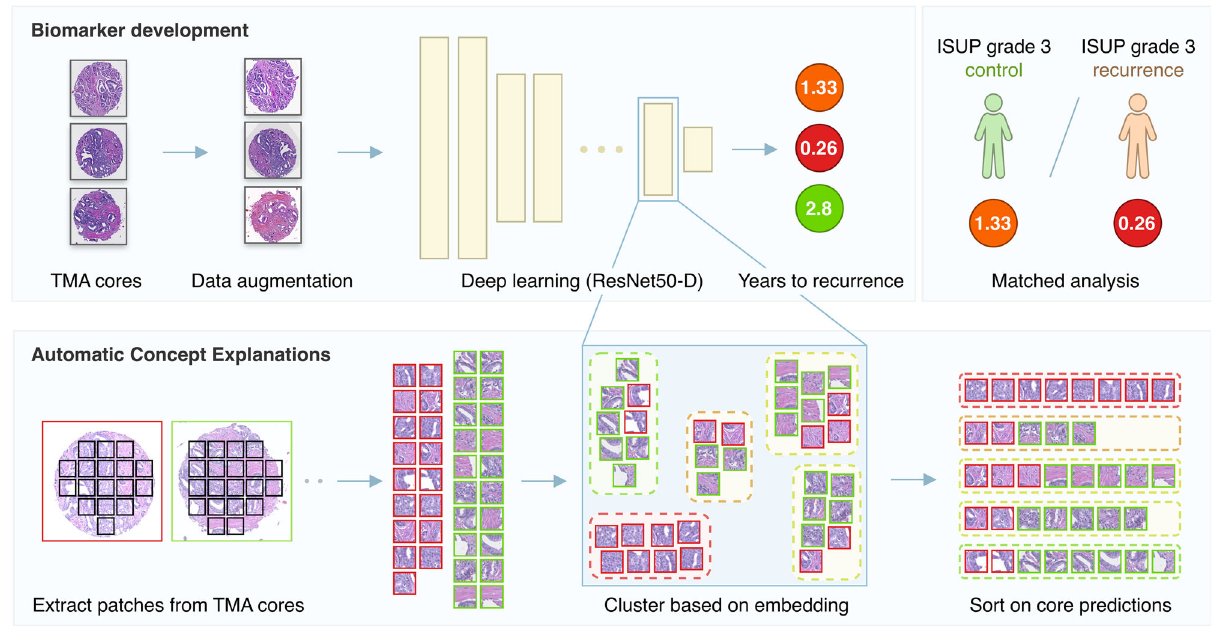
Fig. 1 Overview of the methods summarizing the biomarker development and the Automatic Concept Explanations (ACE) process. Cores were extracted from TMA slides and used to train a neural network to predict the years to biochemical recurrence. On the nested case-control test set, a matched analysis was performed. For ACE, patches were generated from the cores, inferenced through the network and clustered based on their intermediate